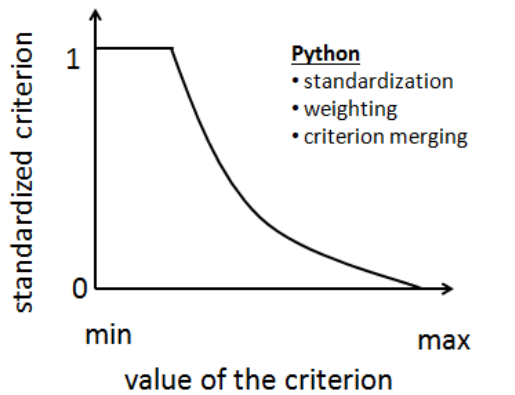
Figure.3 An example of criterion processing in Python